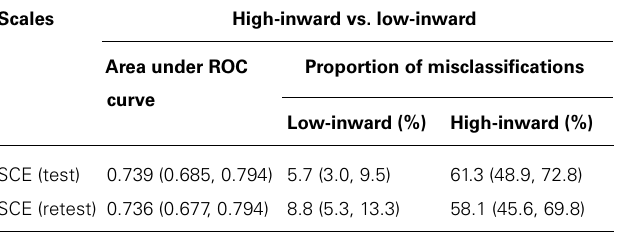
Table 4 |Assessment of construct validity. Scales